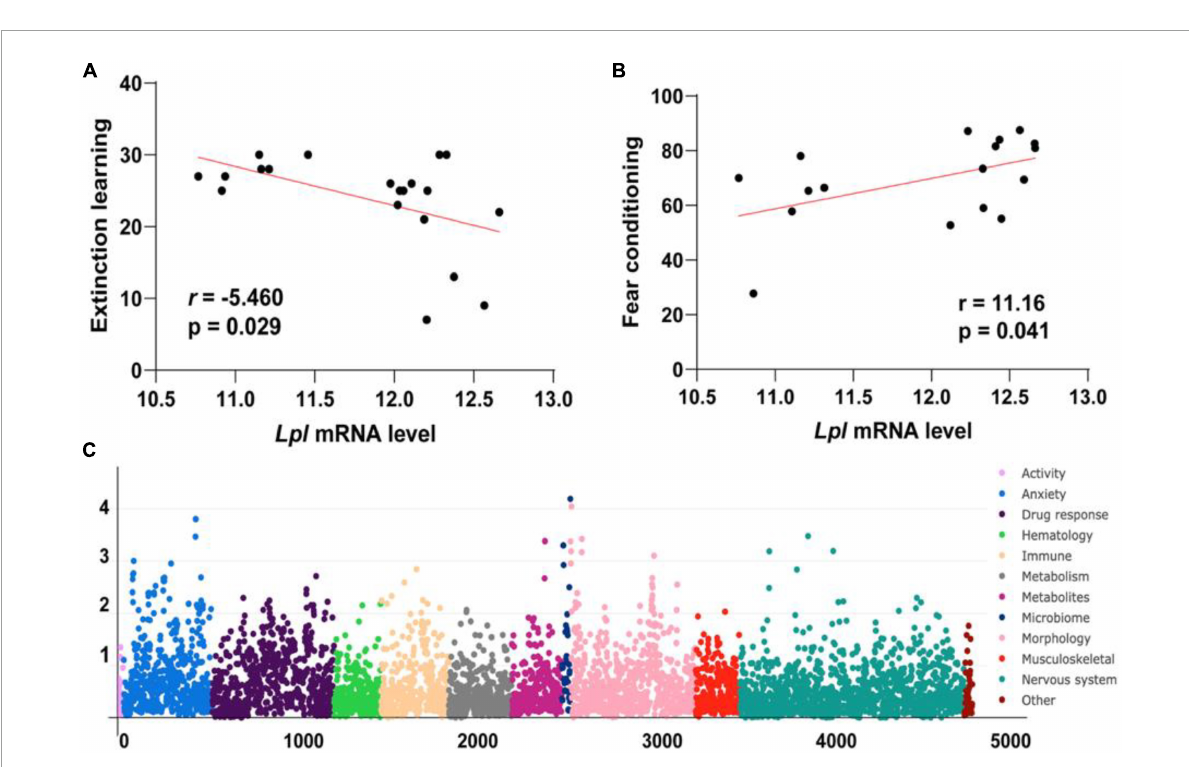
FIGURE2 Lpl is associated with multiple cognition-related traits. Scatter plots of the correlations between the expression of Lpl and extinction learning (A) and fear conditioning (B) . The Pearson correlation coefficient was used to determine the relationship. Manhattan plots showing the Lpl-associated phenotypes in BXD mice (C) . This analysis was done on systems genetics (https://systems-genetics.org/) with the multi-locus mixed-model approach. The clinical phenome was grouped into 11 broad categories based on general biological ontologies, including activity, anxiety, drug response, hematology, immune, metabolism, metabolites, microbiome, morphology, musculoskeletal, and nervous system. P -values were adjusted with the Bonferroni’s